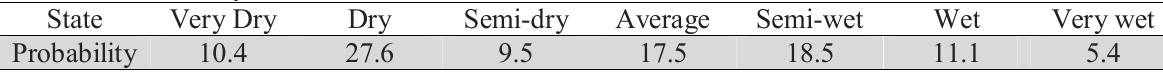
The results of steady